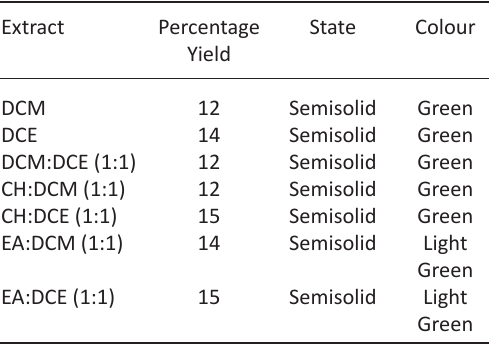
Table 1. Physical data of the extracts of O. europaea leaves Extract